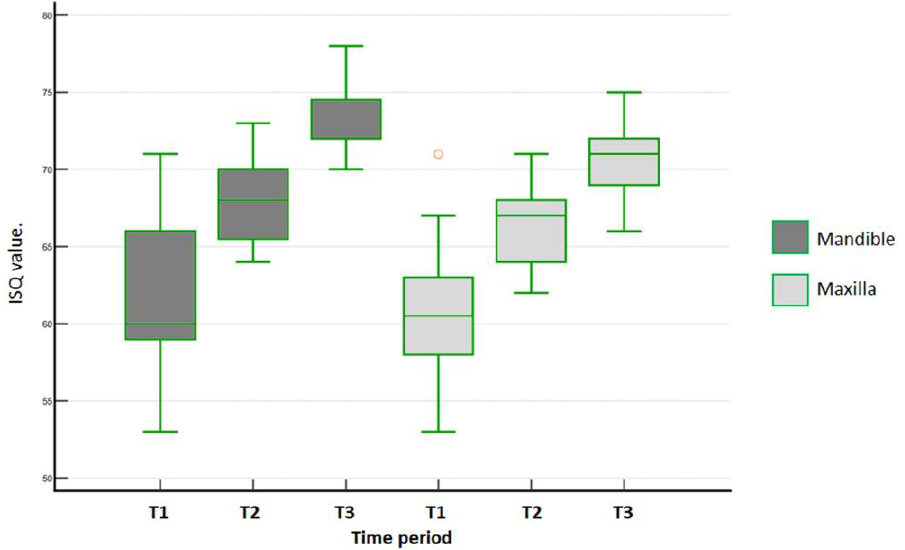
Figure 7. Data distribution of B-L ISQ values measured for MAE group within each arch in each time period (T1 = baseline; T2 = 30 days; and T3 = 45 days). Outlier values are indicated in orange.